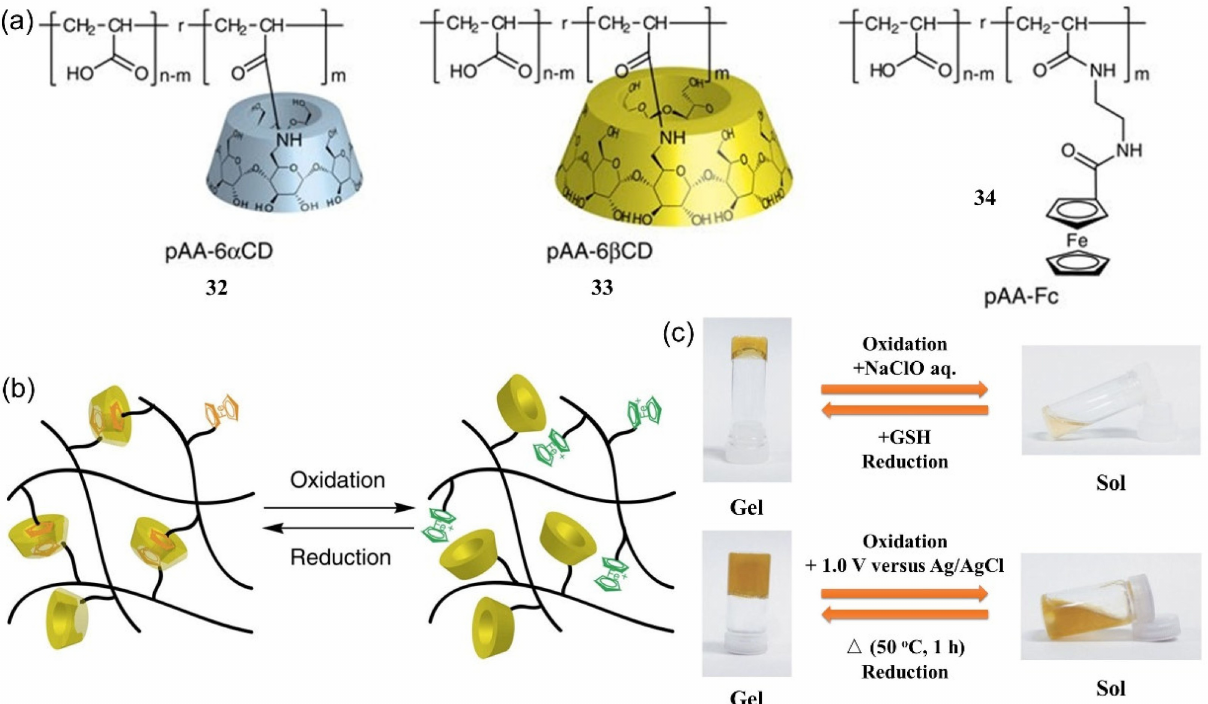
Figure 12. ( a ) Chemical structures of the host polymers 32 and 33 and the guest polymer 34 . ( b ) Schematic illustration of sol − gel transition. ( c ) Sol − gel transition experiment using chemi- cal reagents and electrochemical reactions. Adding NaClO aq. to the 33 / 34 hydrogel induced a phase transition into the sol state, and continuous addition of GSH to the sol recovered the elasticity to yield the hydrogel again. Electrochemical oxidation (+1.0 V versus Ag/AgCl) transformed the hydrogel into sol, whereas reduction recovered the viscosity, reverting it back to a hydrogel. Reprinted with permission from Ref. [62]. Copyright (2012), Nature Publishing Group.